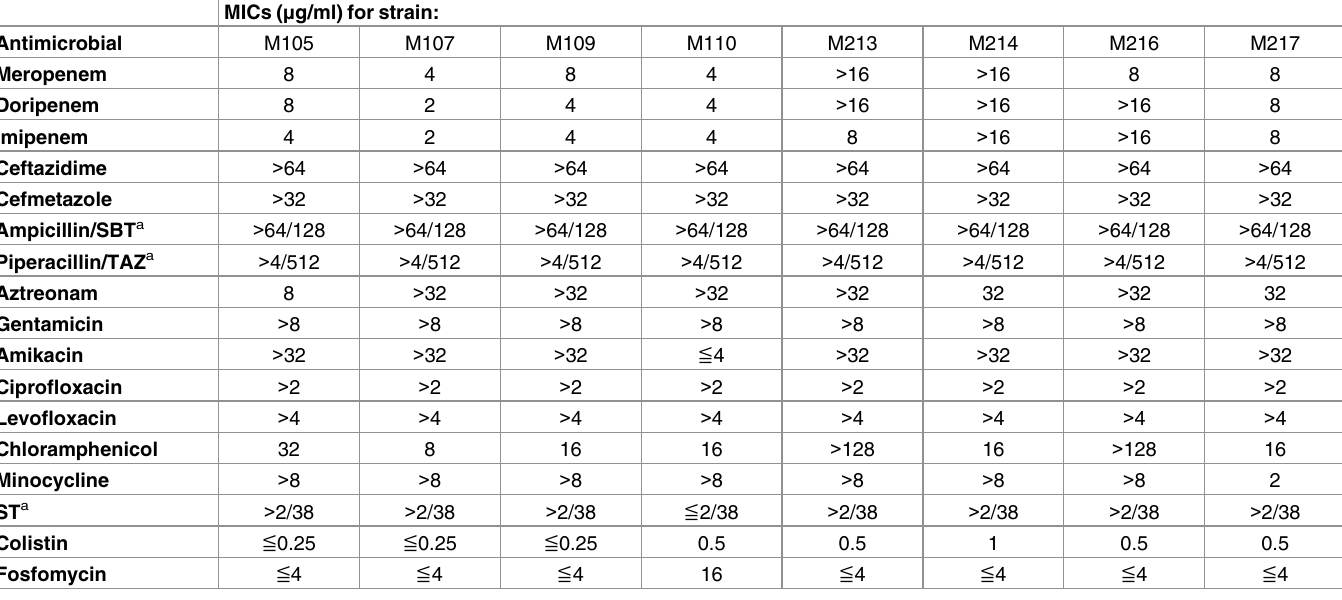
Table 1. MICs of antimicrobial agents for E . coli clinical isolates from Myanmar. MICs ( μ g/ml) for